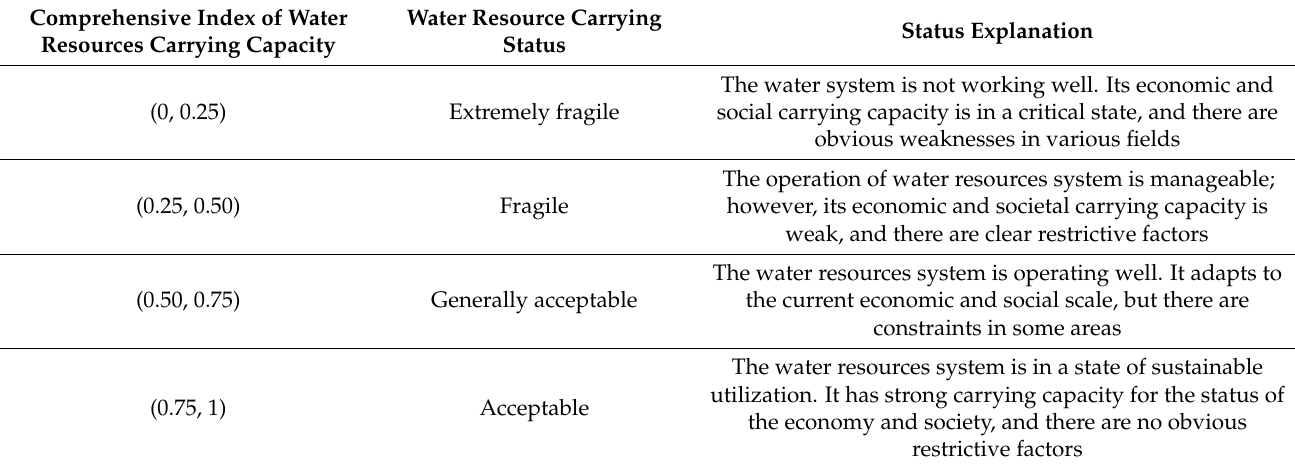
Table 4. Evaluation standard of comprehensive index of water resources carrying